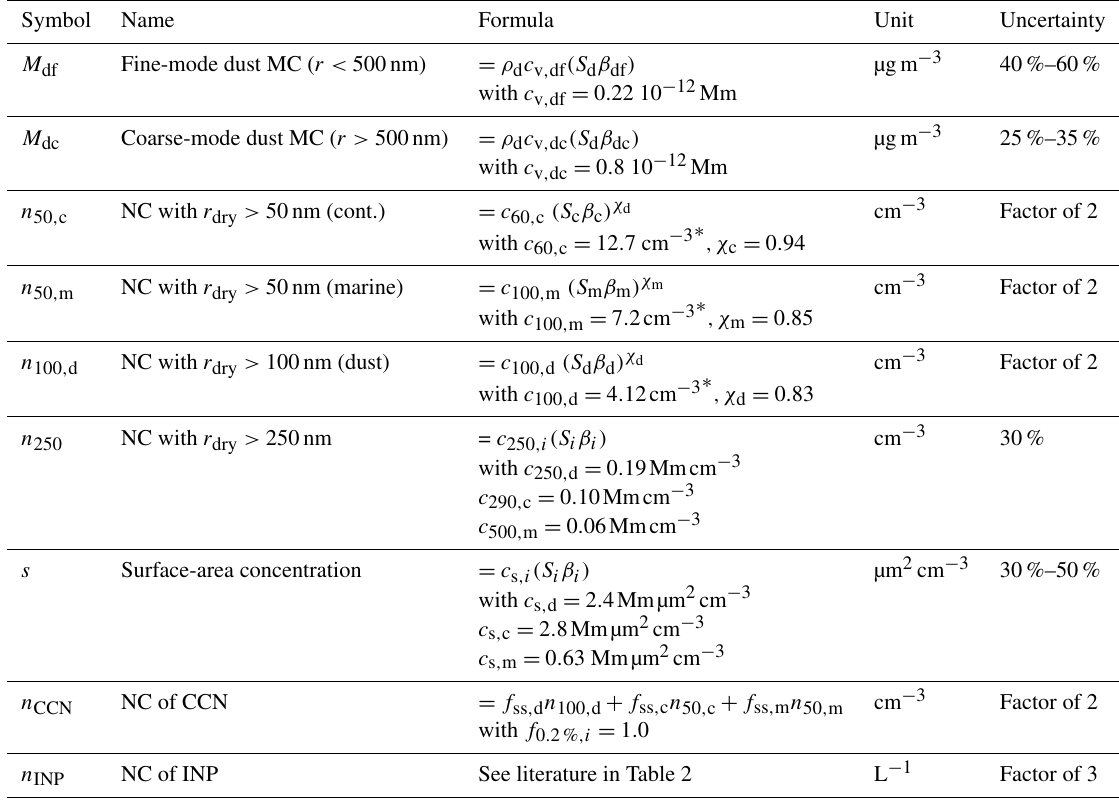
Table 1. List of abbreviations, formulas, and uncertainties for the lidar-derived input parameters to estimate CCN and INP number concen- trations (Mamouri and Ansmann, 2016) and for the separation of fine- and coarse-mode mass concentration (Mamouri and Ansmann, 2017). For Saharan dust the updated conversion factors of Ansmann et al. (2019) are used. All conversion factors are given for a lidar wavelength of 532nm. In the following, the indices d, c, and m represent the aerosol types dust (df – fine-mode dust – r < 500nm; dc – coarse-mode dust – r > 500nm) and continental and marine particles, respectively. The extinction coefficient is calculated as the product of the lidar ratio S i ( S d = 55sr; S c = 50sr; S m = 20sr) and the backscatter coefficient β i of the aerosol component i . NC and MC stand for particle number concentration and mass concentration, respectively. The density ρ d of dust is 2.6gcm − 3 .